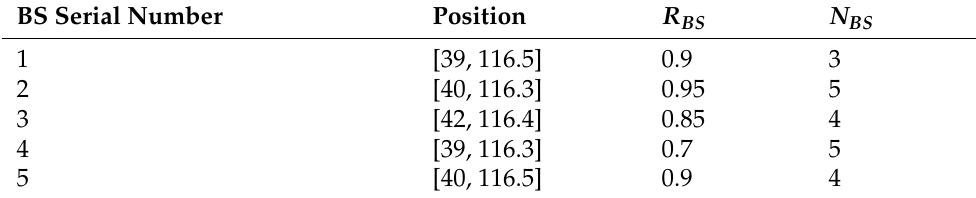
Table 7. Simulation setup for BSs with unknown user distribution.